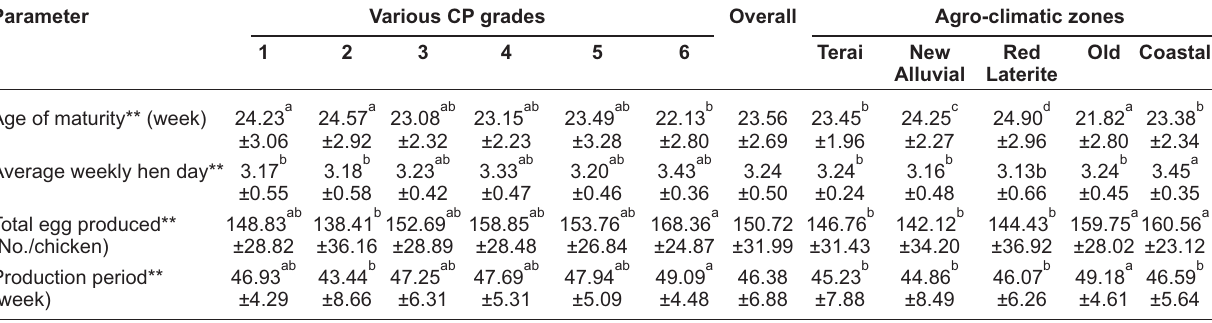
Table-2: Egg production features of RIR chickens reared at backyard obtained by using initial commercial feed followed by various supplemented feed used in farming practices in different agro-climatic zones of West Bengal, India.